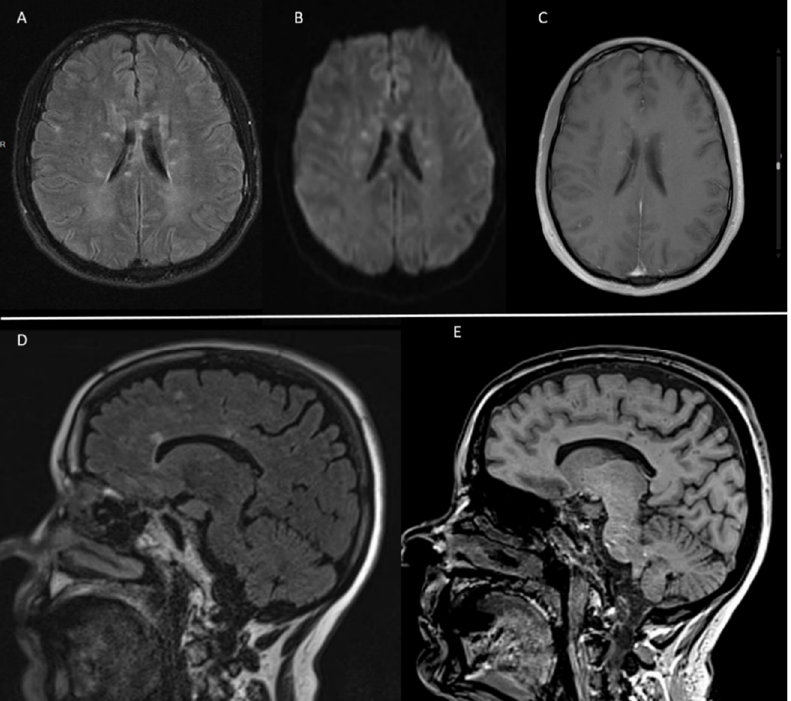
Figure 1. ( A ) Axial images of brain MRI on FLAIR sequence showing bilateral hyperintense lesions with preferential involvement of the corpus callosum. ( B ) Diffusion weighted sequence displaying bilateral acute small infarcts. ( C ) Some of the lesions presented contrast enhancement on T1 weighted sequence. ( D , E ) Sagittal images on FLAIR sequence and 3D-MPRAGE showing several characteristic “snowball” lesions in the corpus callosum.